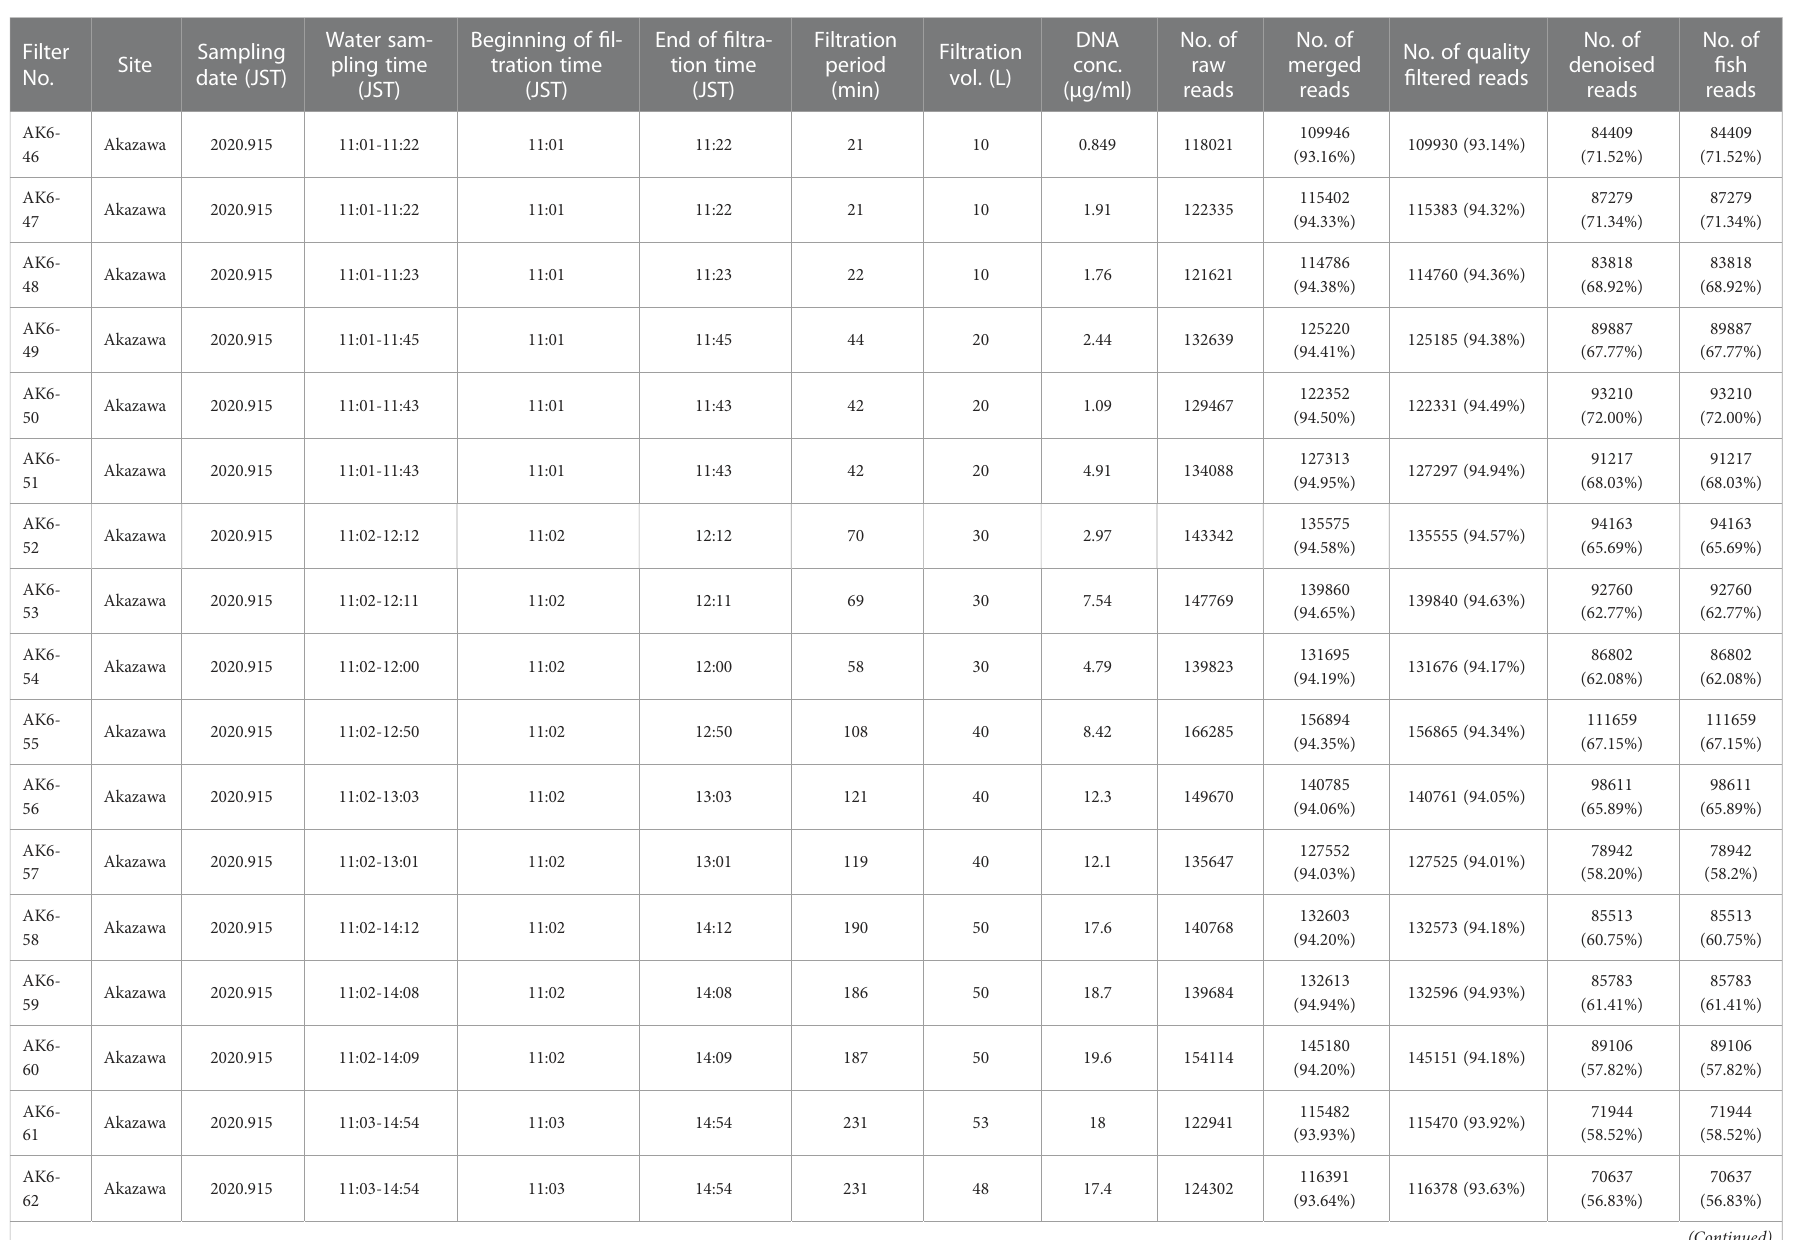
TABLE 1 Summary of fi ltered samples with fi ltration volume, recovered eDNA, read number of data processing, and taxon assignment.